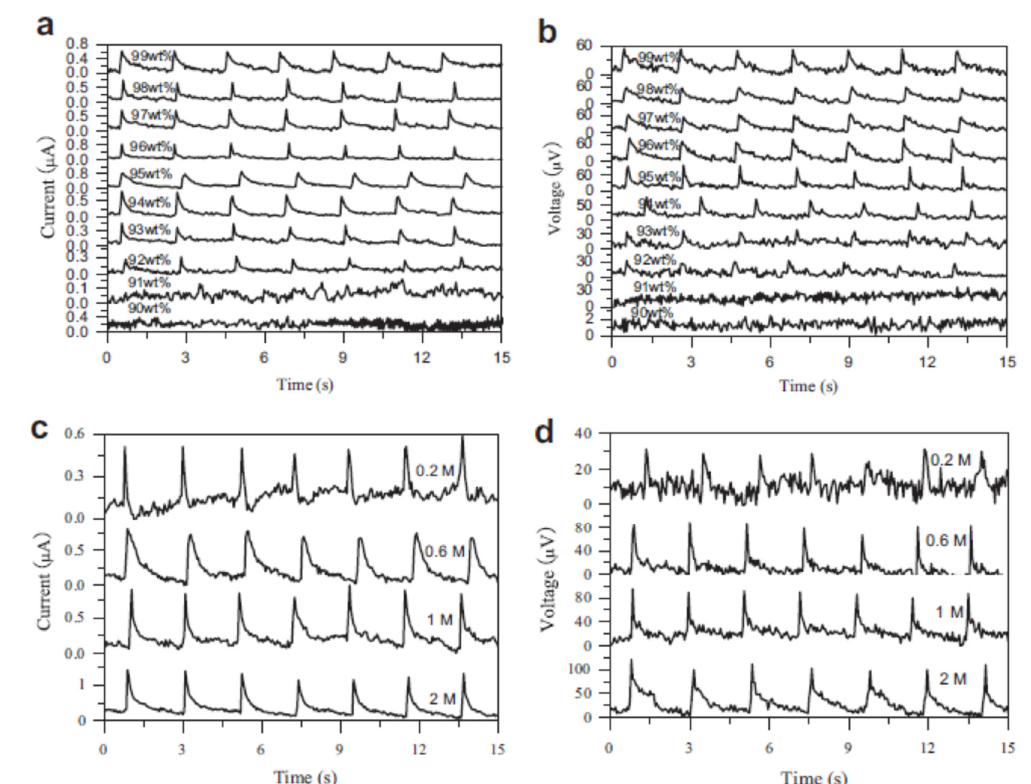
Figure 14. ( a ) Current and ( b ) voltage signals produced by dropping simulated raindrops (0.6 M NaCl aqueous solution) on G-CB/PTFE electrodes with various G-CB dosages of all-weather solar cells. ( c ) Current and ( d ) voltage signals produced by dropping simulated rain droplets (NaCl aqueous solutions at different concentrations) on 95 wt% G-CB/PTFE conducting electrode of the all-weather solar cell. Reproduced with permission from [39] © 2021 Elsevier Ltd.